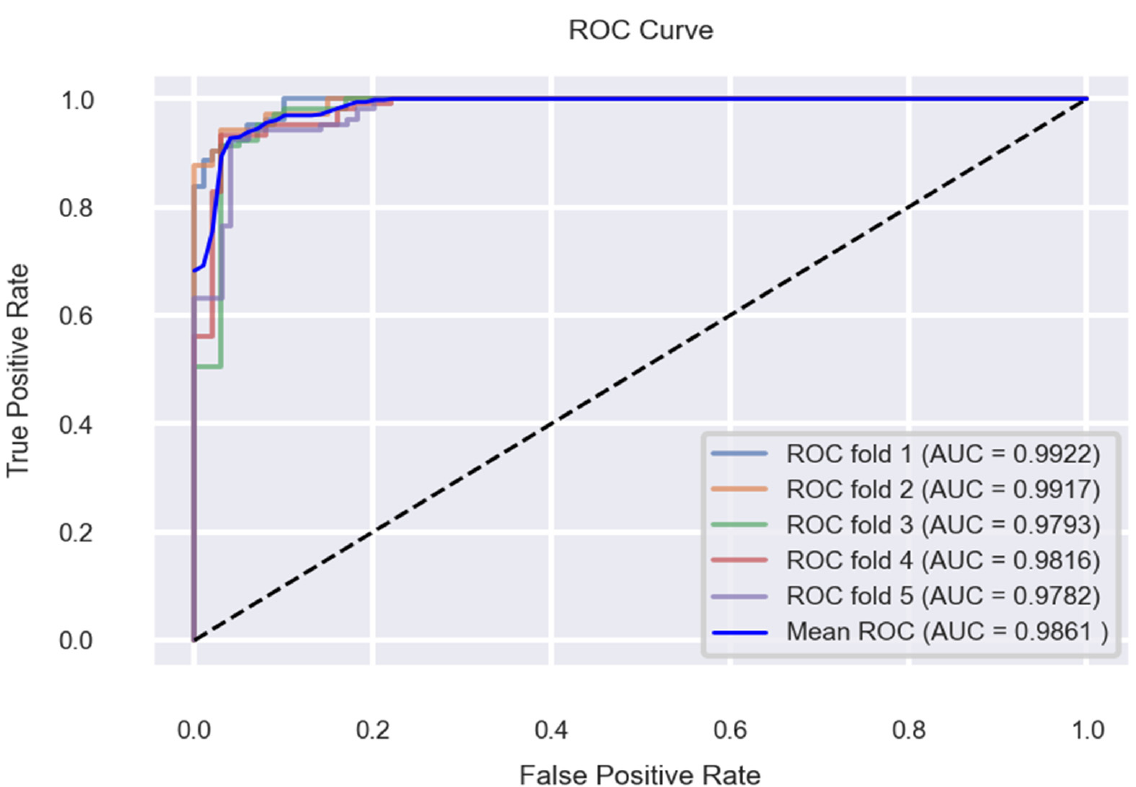
Figure 23. Stratified (K = 5)-Fold Cross-validation Results for Logistic Regression (ROC-AUC).